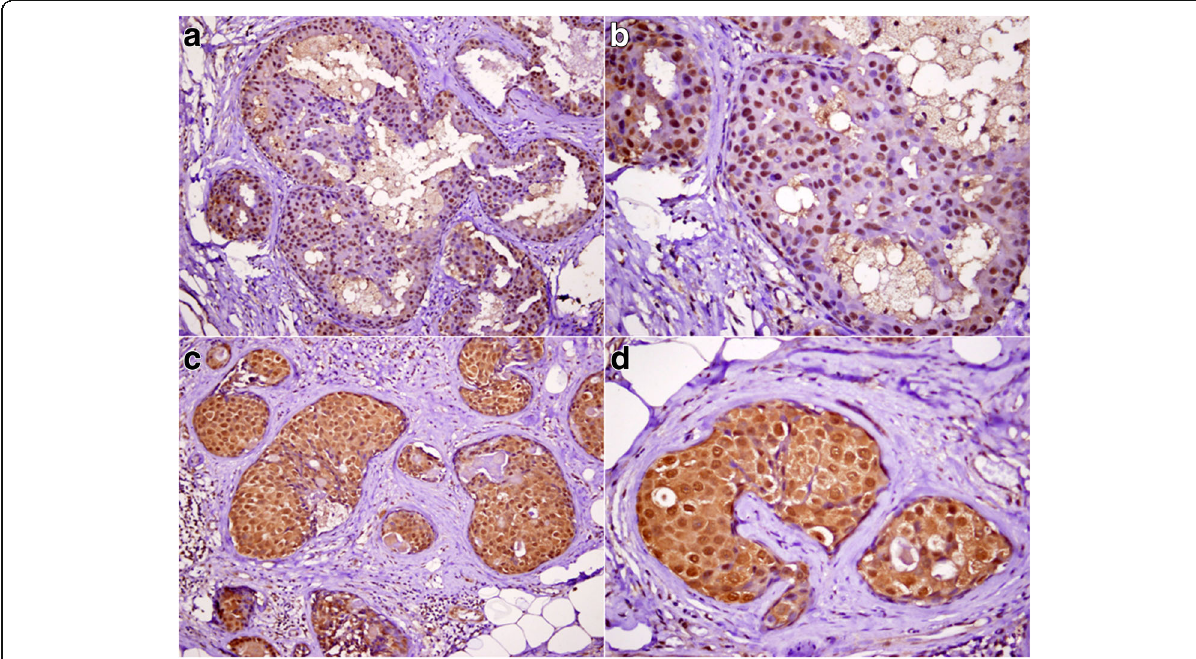
Fig. 2 FOXP1 expression patterns in DCIS. FOXP1 immunostaining was observed in the nuclei of tumor cells ( a ×200, b ×400) or both the nuclei and cytoplasm ( c ×200, d